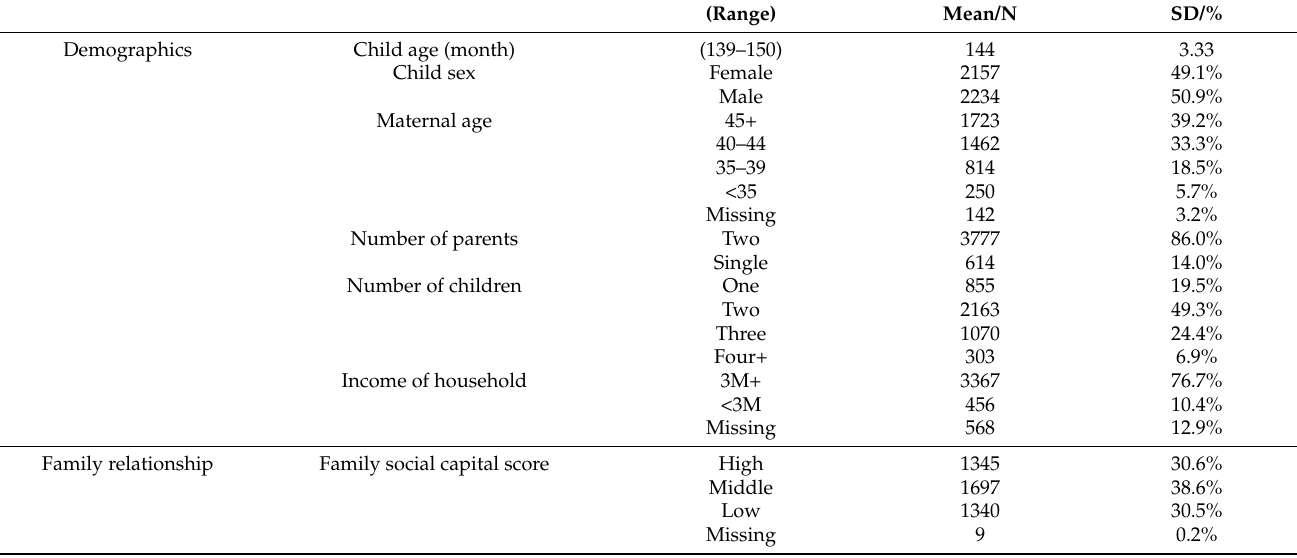
Table 1. Demographic and other variables of